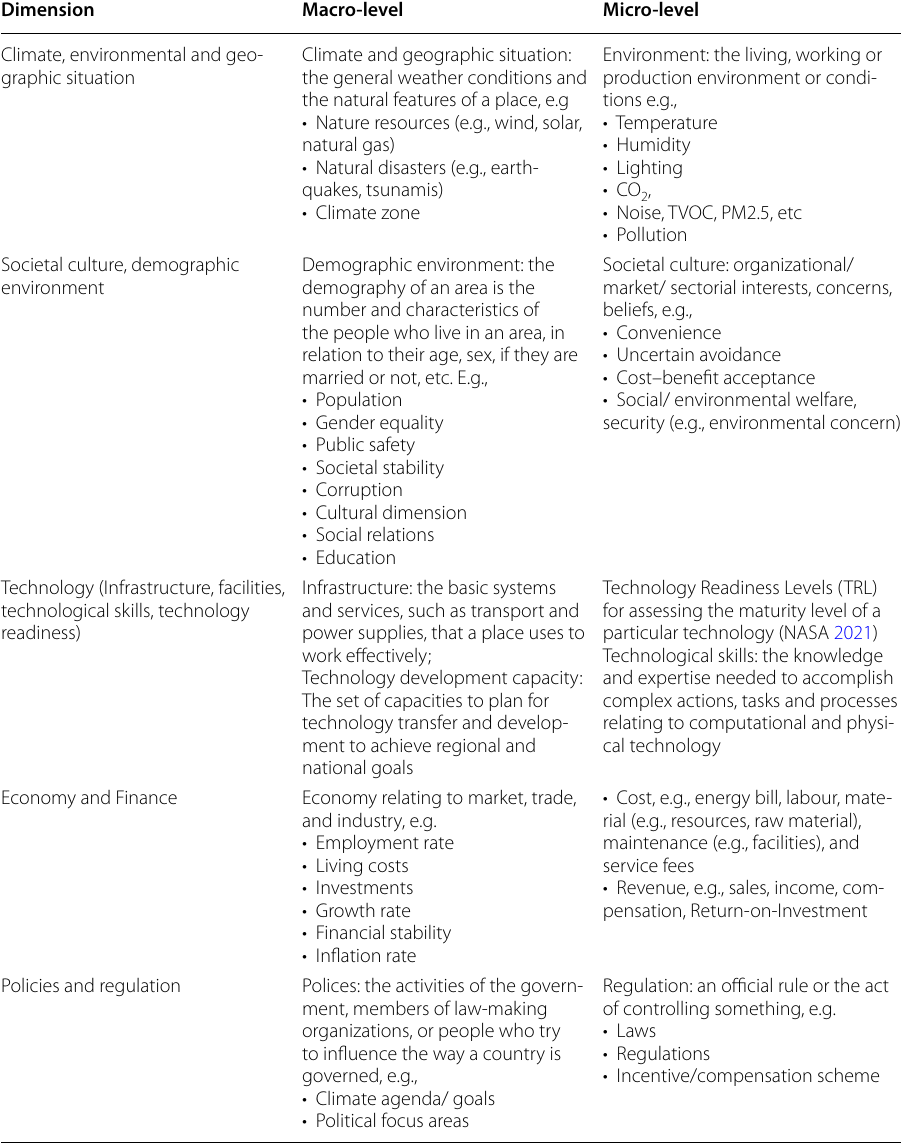
Table 7 Macro and micro levels of the five CSTEP dimensions